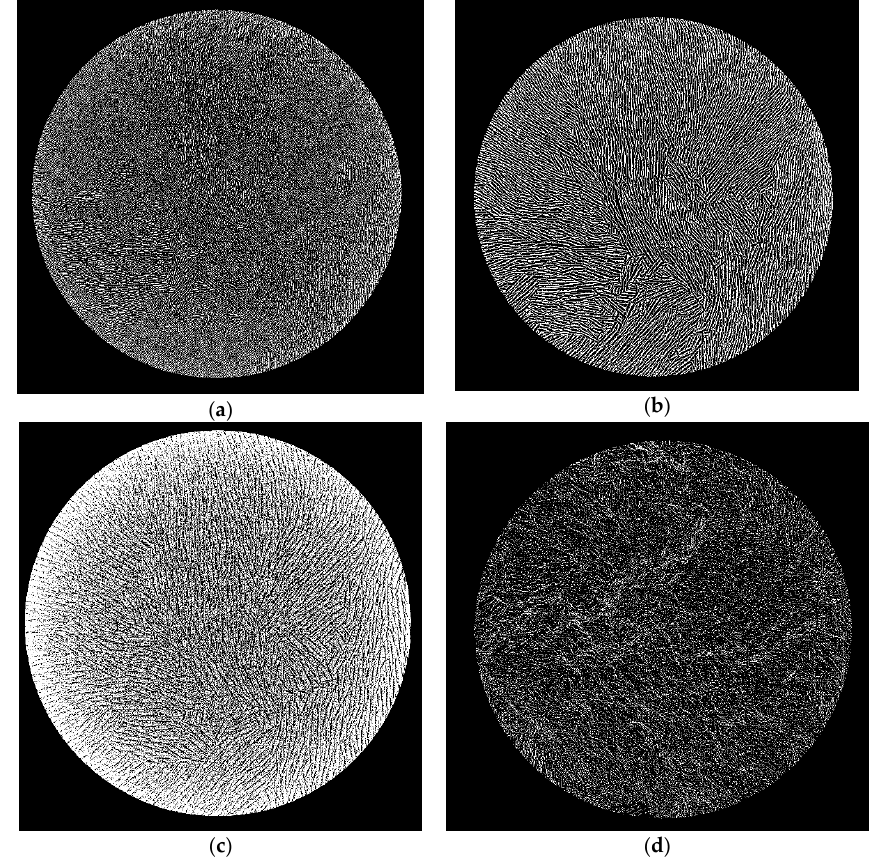
Figure 5. X-ray micro-computed tomography images of cross-sections through monoliths at different heights, h (cf. Figure 1a). ( a ) φ v = 0.128, h = 0.90; ( b ) φ v = 0.128, h = 0.5; ( c ) φ v = 0.128, h = 0.18; ( d ) φ v = 0.032, h = 0.9.